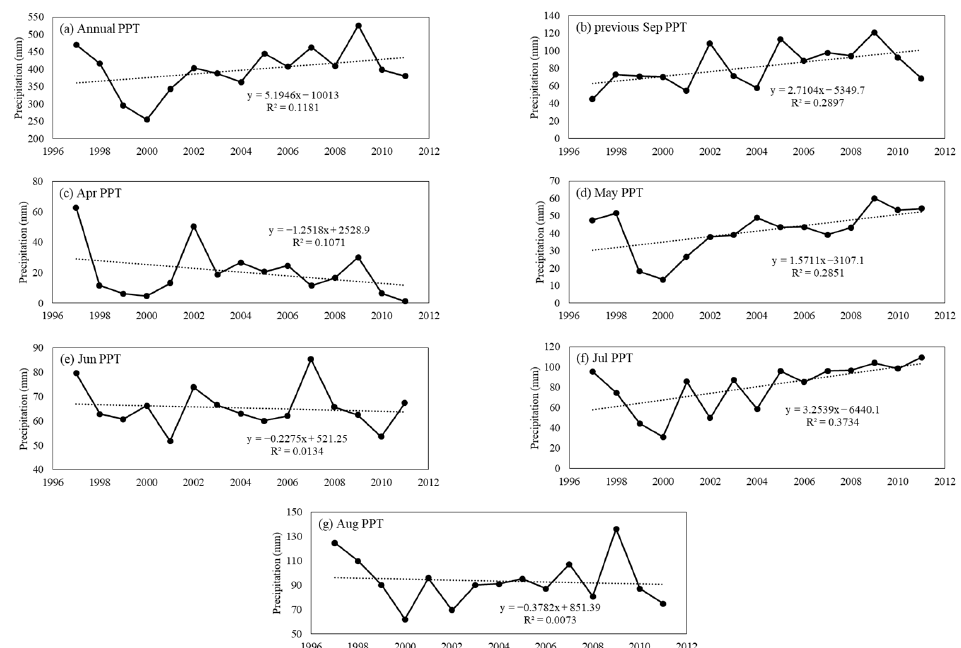
Figure A1. Trends of annual and monthly precipitation during 1997–2011. (a) Annual precipita- tion; (b) previous September precipitation; (c) April precipitation; (d) May precipitation; (e) June precipitation; (f) July precipitation; (g) August precipitation.